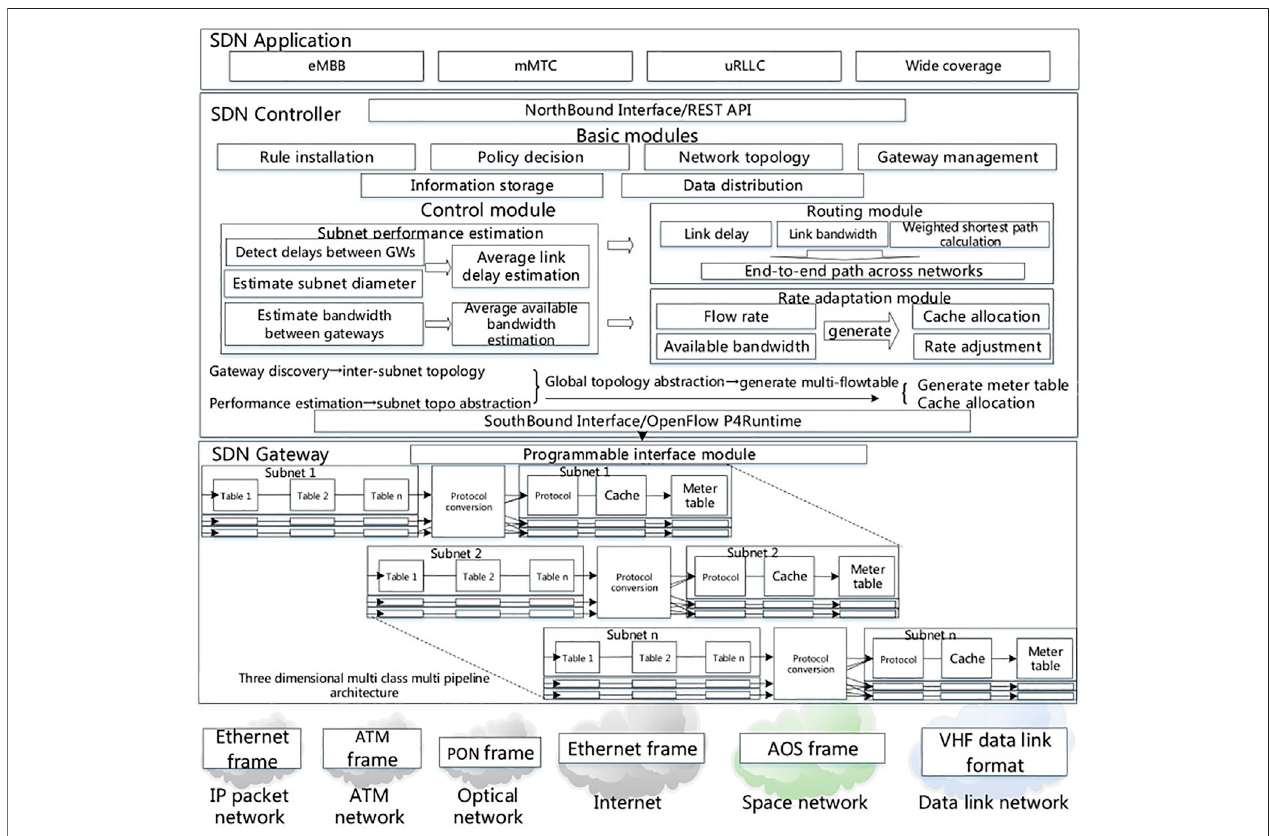
FIGURE 3 | The implementation of the SD-SGN architecture realizing the interconnection of heterogeneous networks.